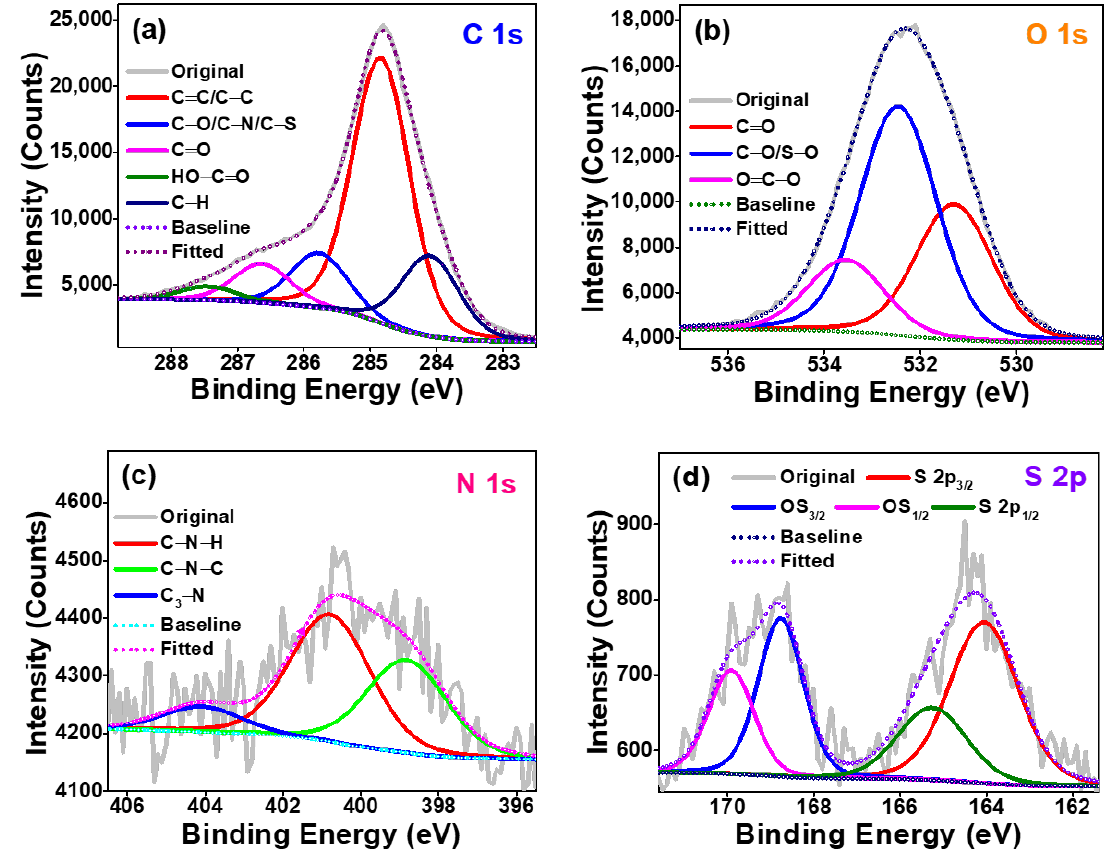
Figure 4. XPS high-resolution spectra with deconvolution peaks of ( a ) C 1s, ( b ) O 1s, ( c ) N 1s, and ( d ) S 2p regions of synthesized H-PCM. ( d ) S 2p regions of synthesized